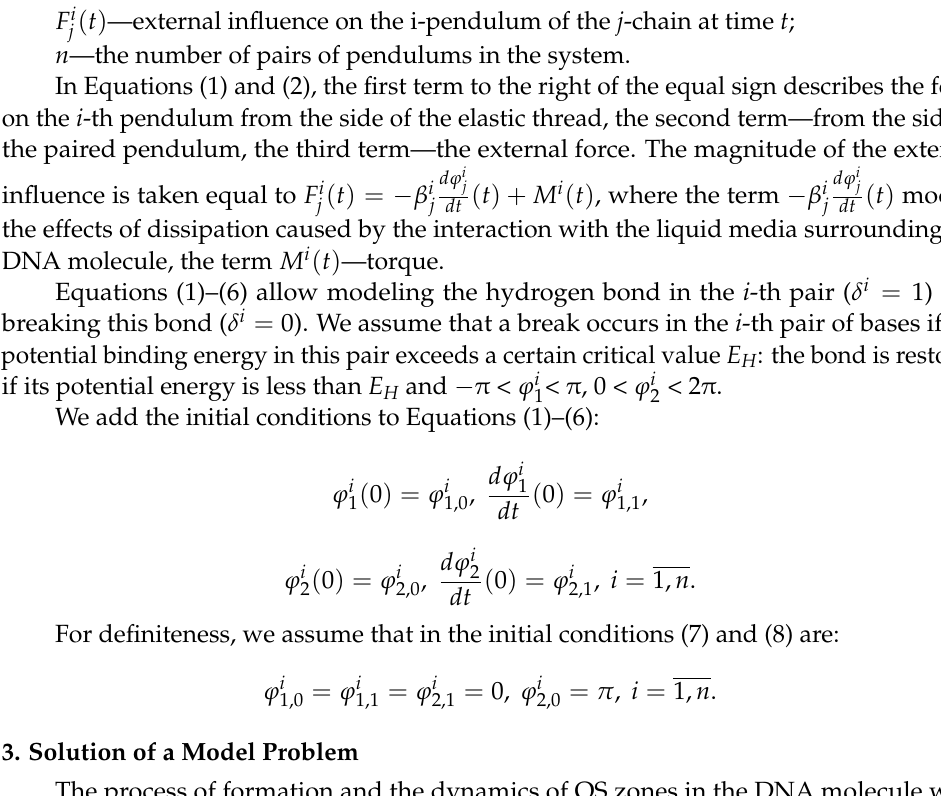
Table 1. Coefficients of Equations (1) – (6). Type of Base